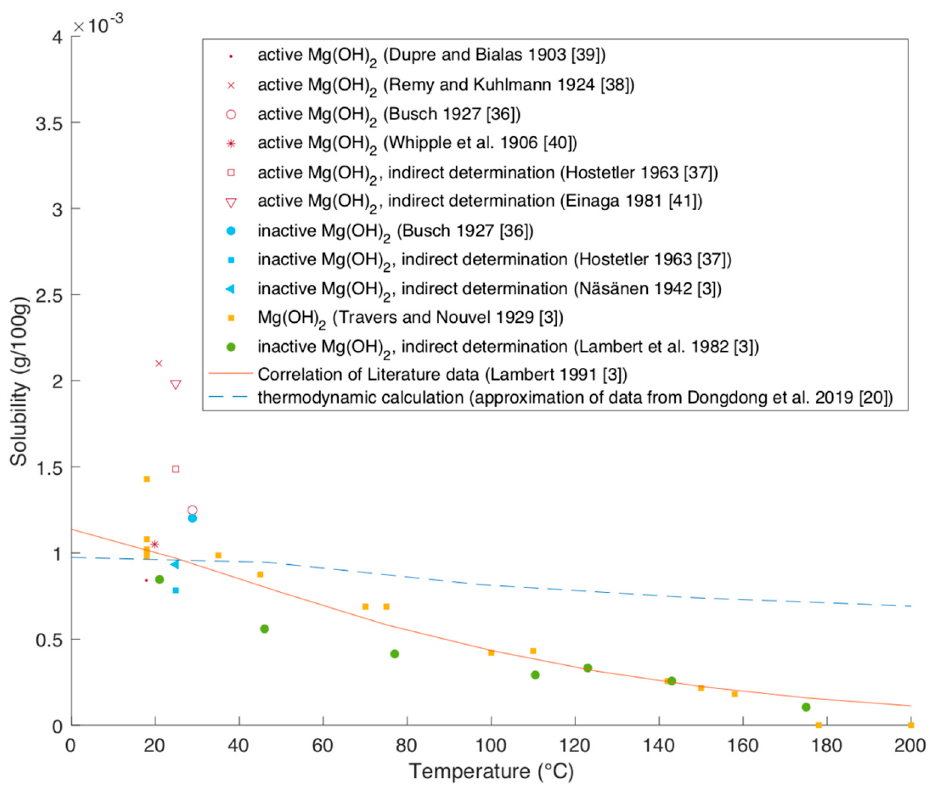
Figure 11. Solubility of Mg( OH) 2 in water [3,20,36–41]. The data from Näsänen (1942), Travers and Nouvel (1929), and Lambert (1982)